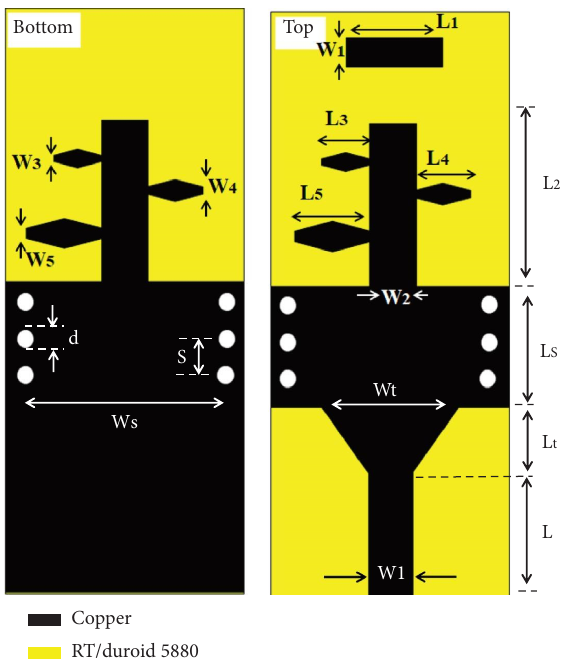
Figure 1: Te structure of the proposed